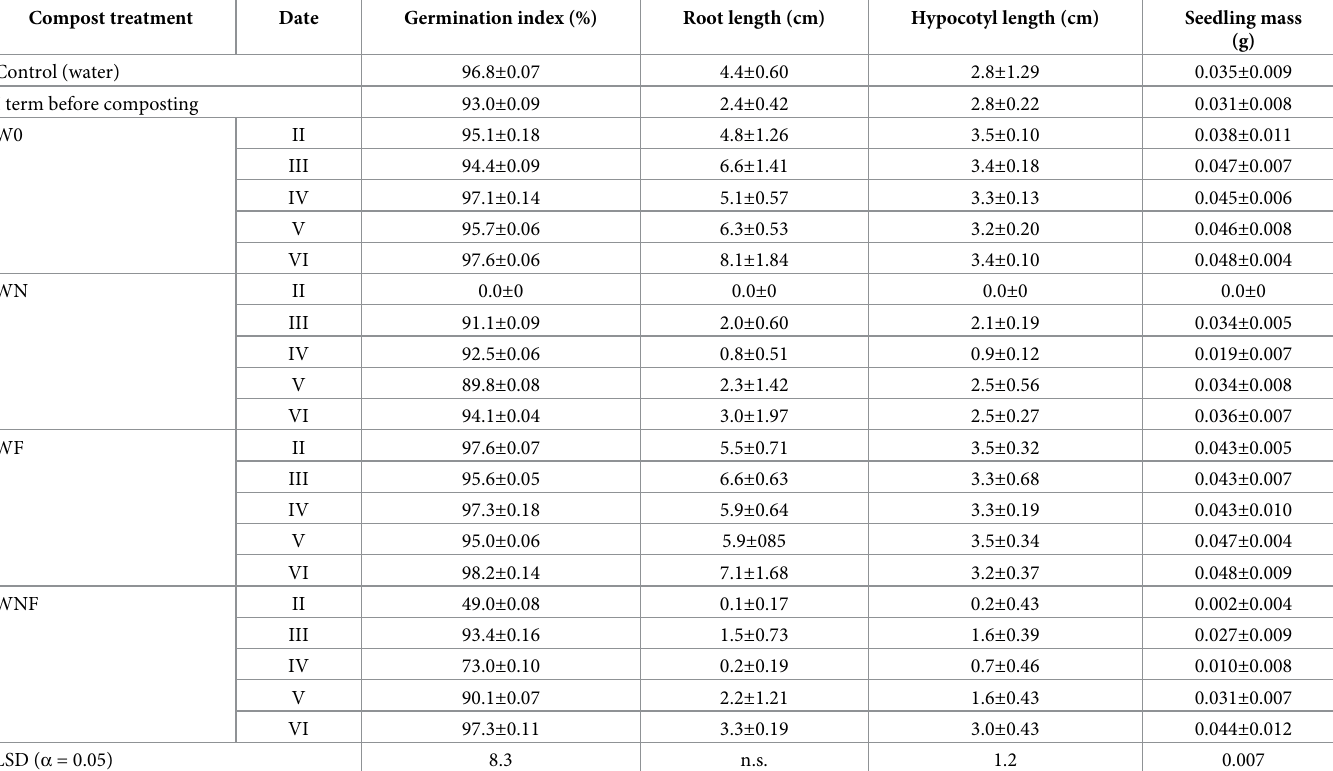
Table 2. Germination capacity and seedlings parameters depend on composting treatment and sampling date (average and standard deviation ( ± ) for different terms of sampling and variants of